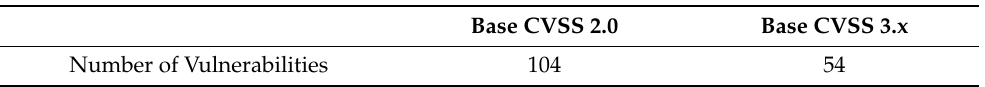
Table 5. Comparison of the number of vulnerabilities detected according to the selected standard for environment B.